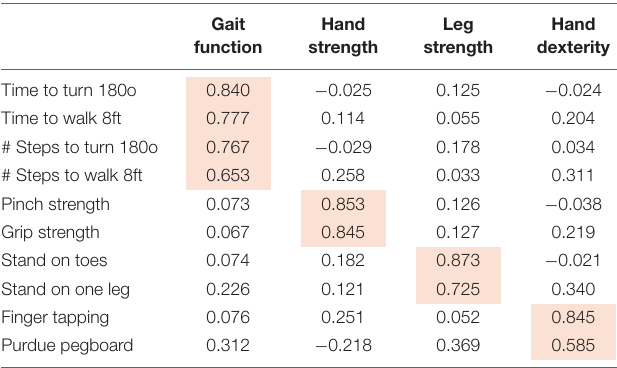
TABLE 1 | Principal component factor analysis* of the 10 performances used to construct the global motor score.